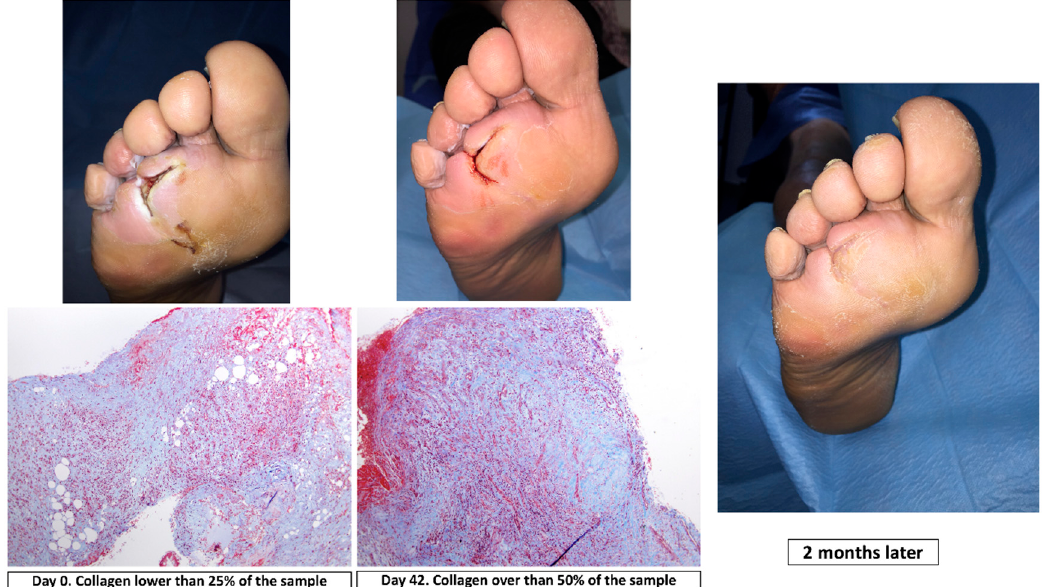
Figure 2. Masson’s trichrome staining (magnification, × 10) at day 0 and day 42, clinical situation and progression of healing in a patient of surgical group.